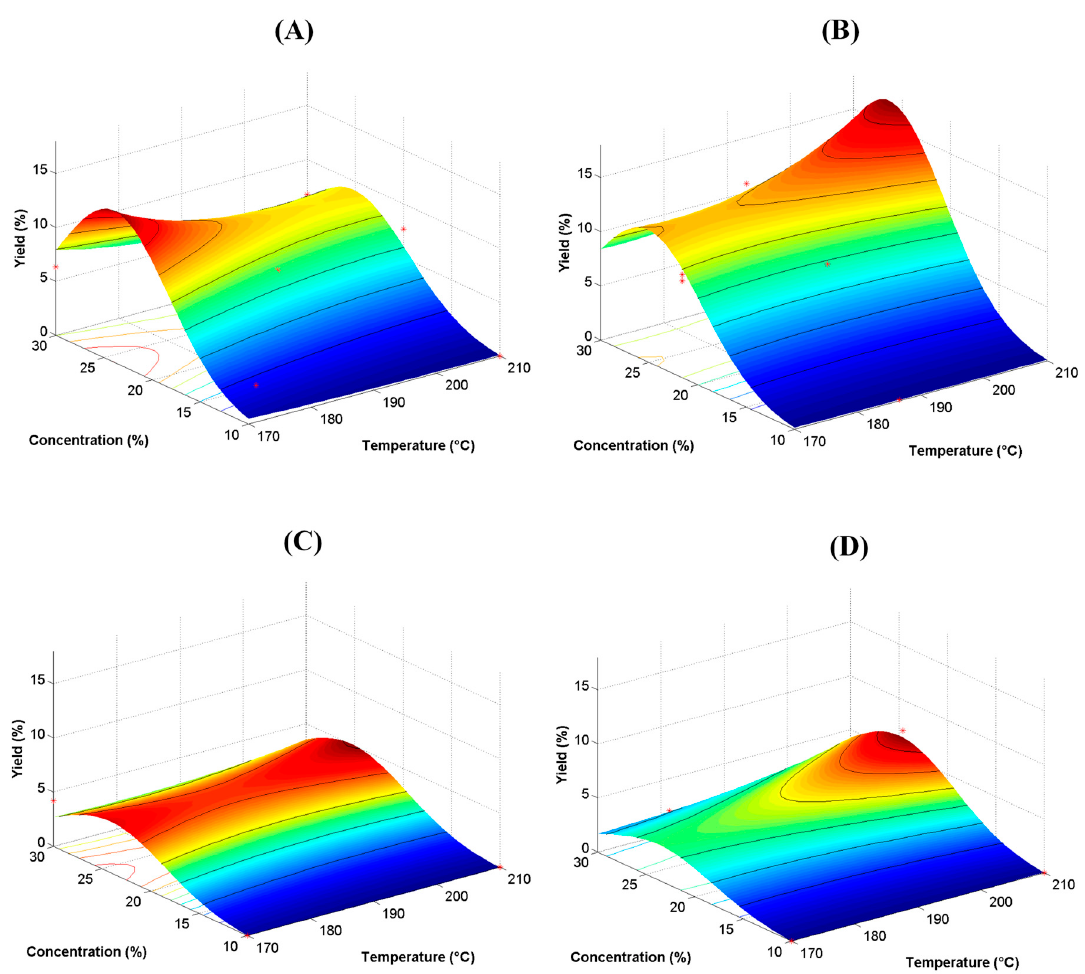
Figure 5. Response surface plots (RSP) for the yield of dry powder. Yield is expressed in percent of recovery (%): ( A ) Mc, ( B ) M10, ( C ) M20, and ( D ) M40.